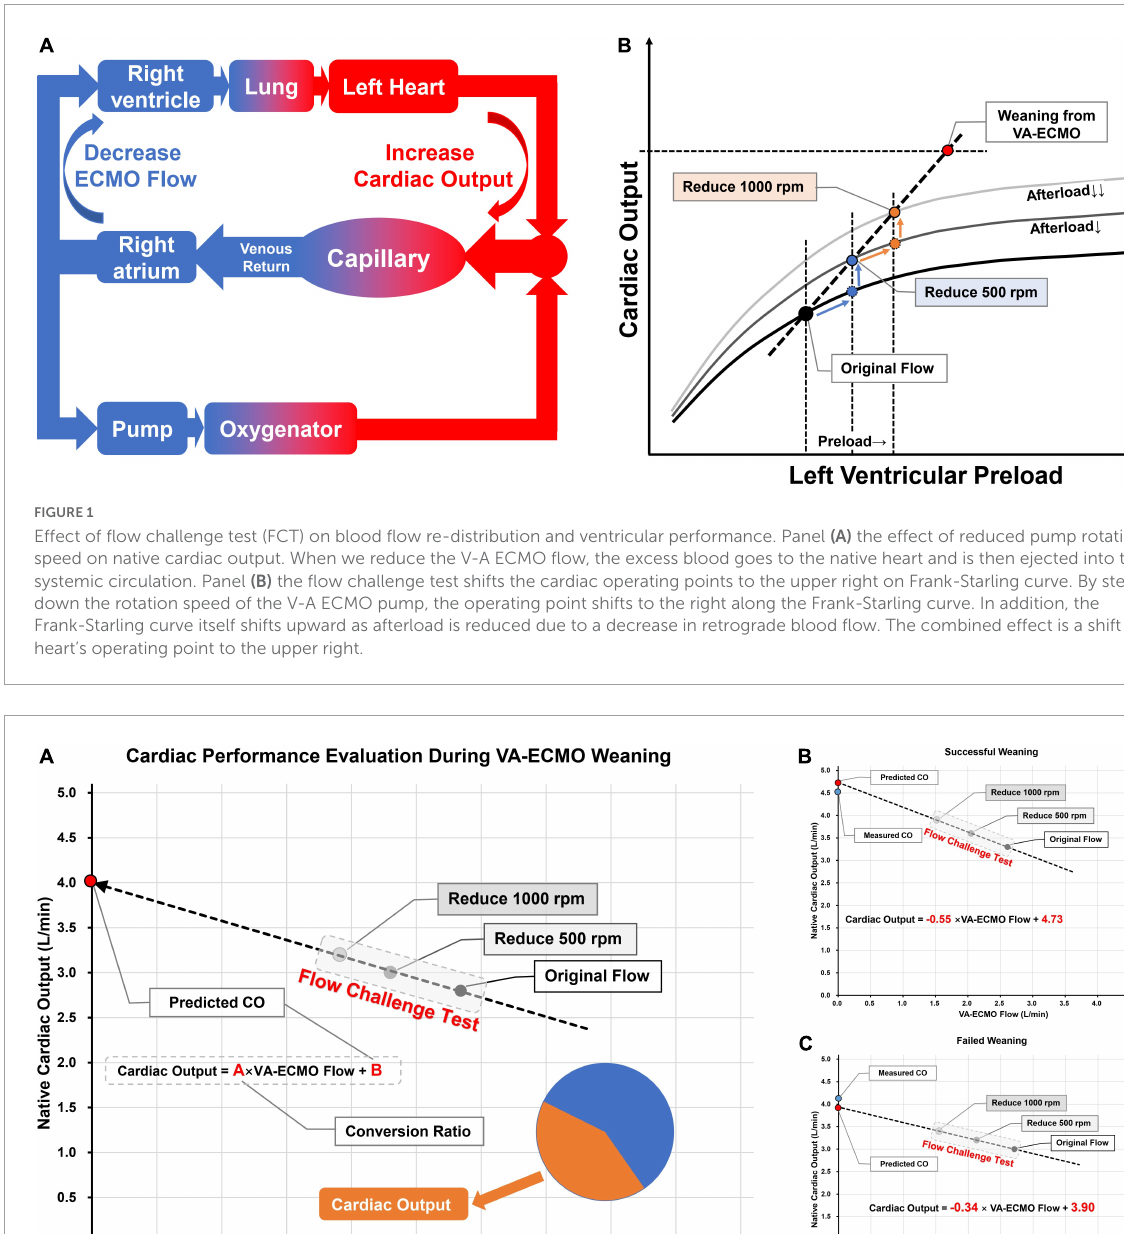
ECMO support for cardiogenic shock. Cardiac function was gradually recovered in both patients, and V-A ECMO blood flow rate was reduced to around 2.5 L/min. During the